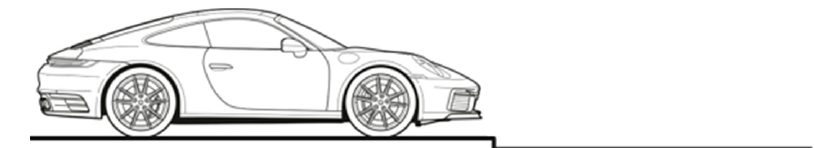
Figure 1. Vehicle before driving over a falling edge of 30 mm [19].